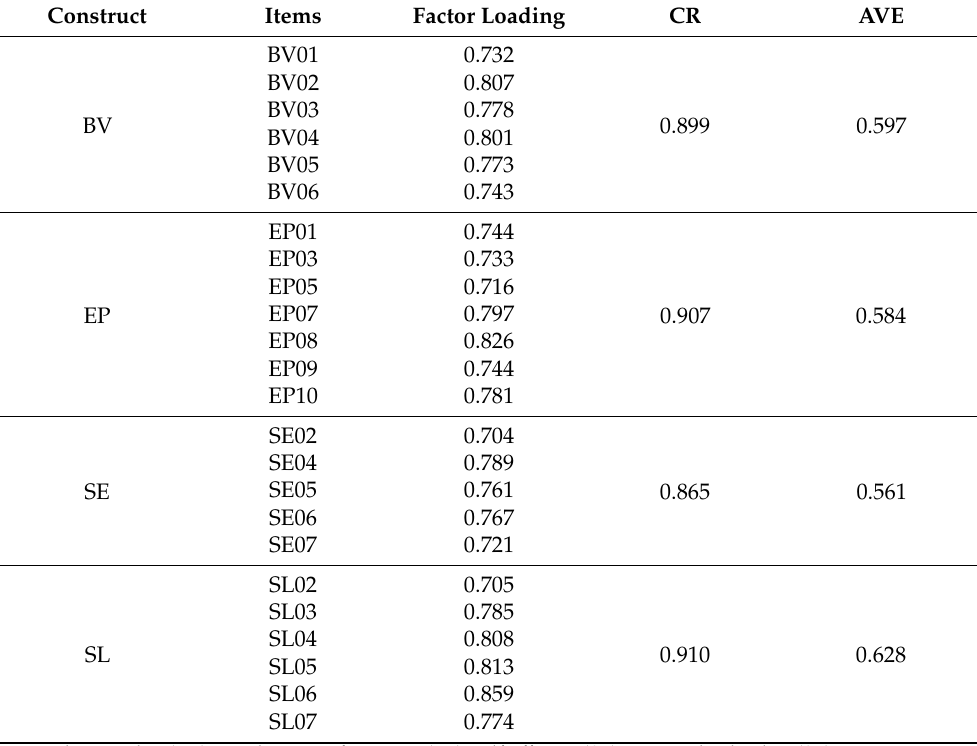
Table 1. Convergent validity